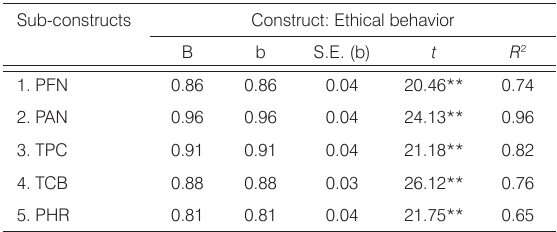
Table 1. Parameter estimates of 5 sub-constructs and their measurement